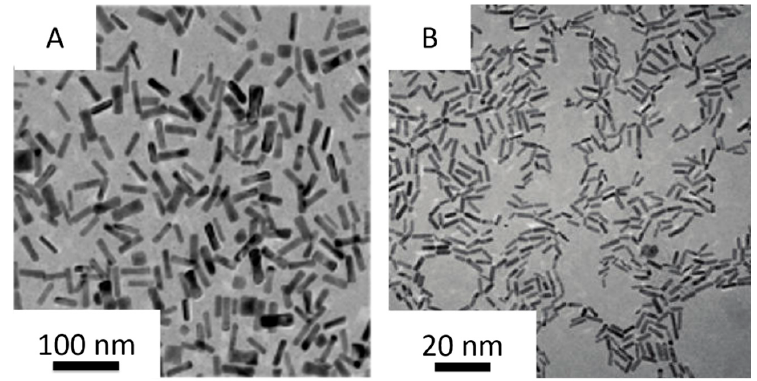
Figure 2. Typical TEM images of the small gold nanorods obtained by Jana et al. [42] (( A ) 1 mM HAuCl 4 , 0.2 M CTAB, 0.2 mM AgNO 3 , 2 mM ascorbic acid, 0.25 μ M BH 4 ), and El-Sayed et al. [37] HAuCl 4 , 0.2 M CTAB, 0.2 mM AgNO 3 , 2 mM ascorbic acid, 0.25 µ M BH 4 ), and El-Sayed et al.